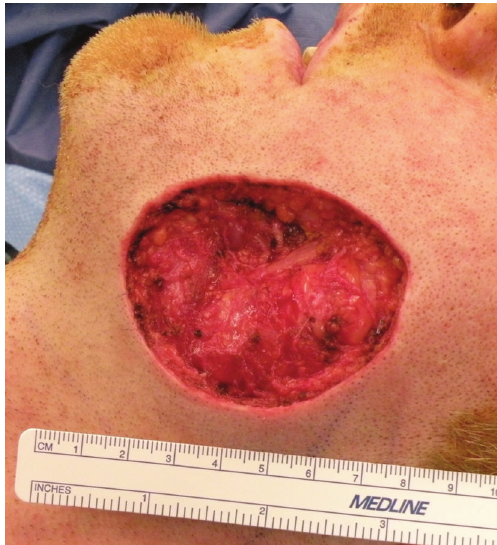
Figure 3: Intraoperative picture of the surgical defect measuring about 5 × 6 cm.